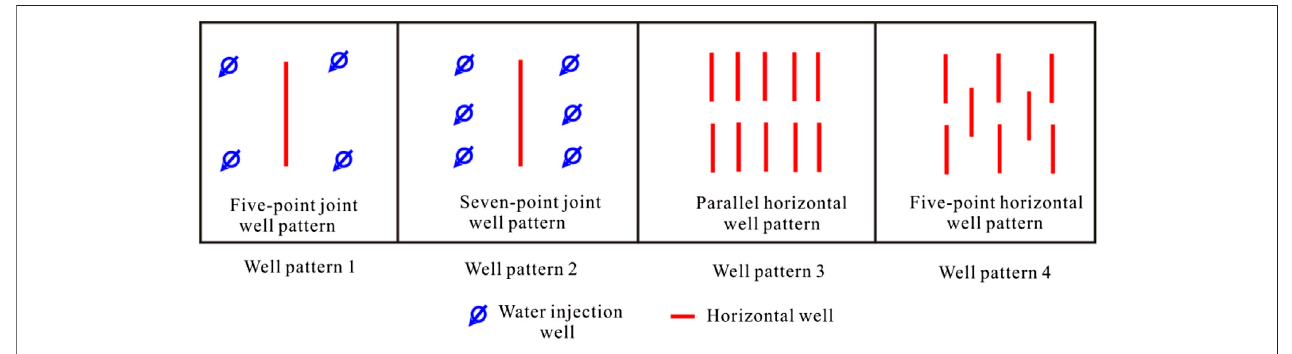
FIGURE 12 | Design of different injection and production well patterns.